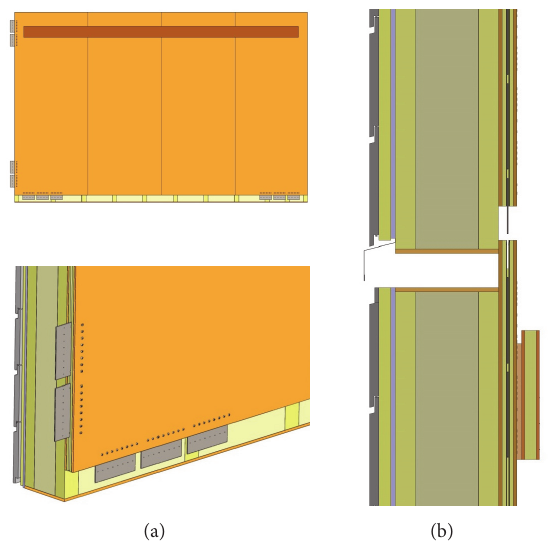
Figure 1: External wall unit of the MFB XL system showing the slotted-in wall-to-wall connections along the bottom and vertical end edge of the wall element: (a) front view (top figure) illustrating a shear wall and left bottom part of the wall (bottom figure). The slotted-in connections are utilized for splicing, anchoring, and load transfer; and (b) an elevated side view showing interface for vertical splicing (the service and finish layers are not shown); the supporting beam on the inner wall surface for the suspended floor elements is also shown.